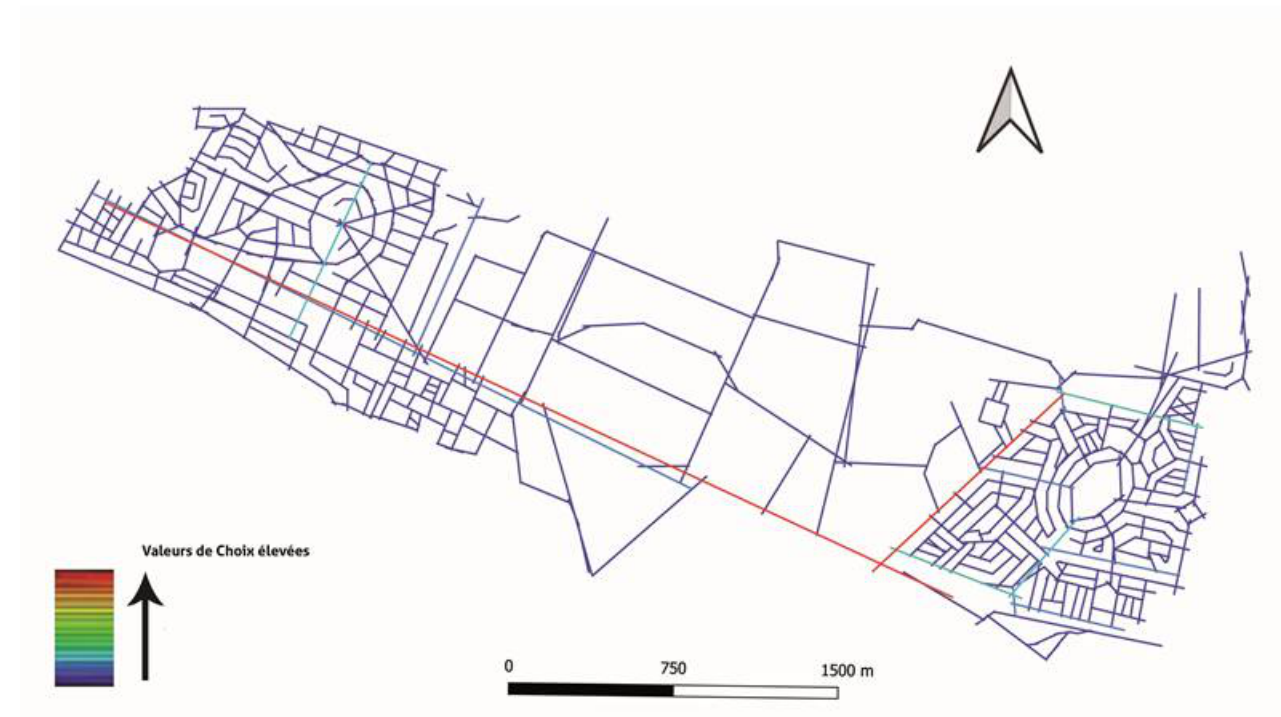
Figure 8. Choice map of Hammem Chott.